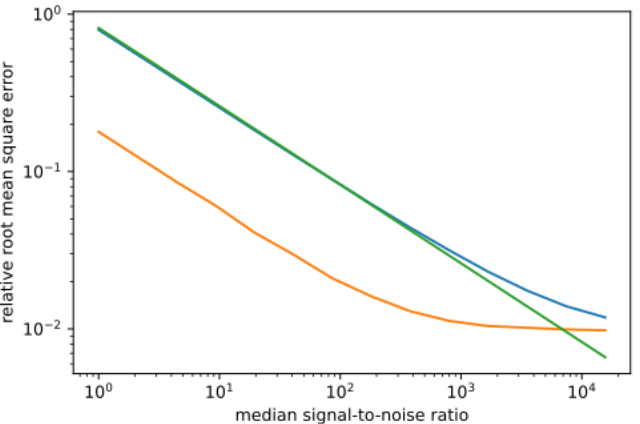
Figure 13. At small signal-to-noise ratios, the SOM-processed data ( yellow ) are a better estimate of the scene than the original noisy observations ( green ). While the SOM provides a good estimate of the original scene, the reconstruction provides a relatively poor estimate of the noisy scene on which it is actually trained ( blue ) because it does not capture the noise